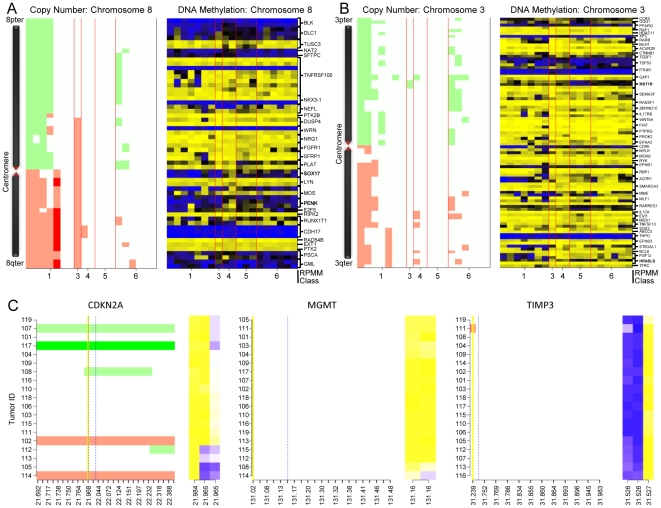
Integration of copy number and methylation values for 19 HNSCCs.Tumor profiles in combined color image plots for A) chromosome 8 and B) chromosome 3 are grouped by RPMM-modeled methylation classes. Methylation values (more methylated = blue, less methylated = yellow) are located to the right, while copy number (red = gain, green = loss) is displayed on the left within each panel. SNP loci are matched to the nearest CpG locus and these matched loci (common to both subpanels) are oriented coordinately along the chromosomes. For legibility, the loci are grouped by gene. Note: Chromosome diagrams are not to scale, but centromeric regions are correctly located between genes. C) Gene-focused copy number and methylation data. The x-axis displays the genomic coordinate (x10-6) for each locus. Vertical yellow lines mark the TSS and dashed blue lines denote locations of the mapped CpG loci, whose values are displayed on the right portions of the plot for each gene. Methylation average β is bright blue for fully methylated and bright yellow for unmethylated. Copy number is displayed on the left plot and SNP loci marked red represent amplified alleles and green for deleted allele calls.